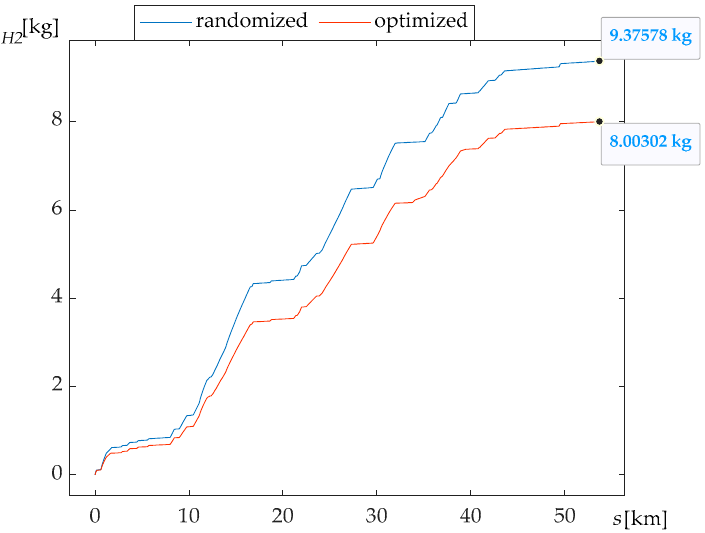
Figure 8. Consumption of the hydrogen (red is optimized, blue is randomized).